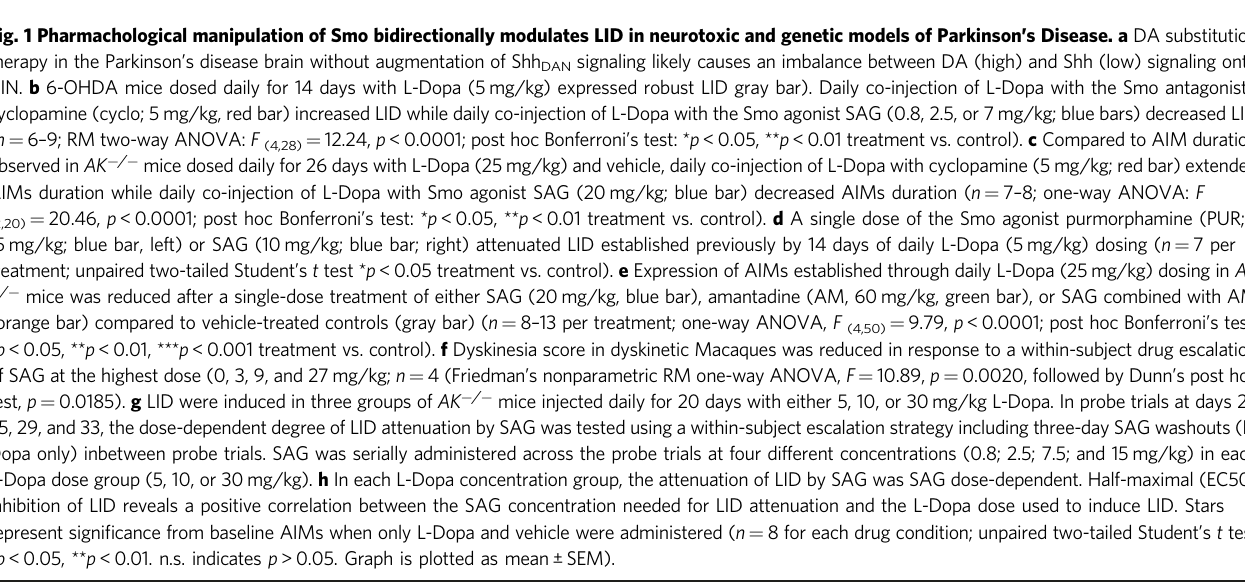
Fig. 1 Pharmachological manipulation of Smo bidirectionally modulates LID in neurotoxic and genetic models of Parkinson ’ s Disease. a DA substitution therapy in the Parkinson ’ s disease brain without augmentation of Shh DAN signaling likely causes an imbalance between DA (high) and Shh (low) signaling onto CIN. b 6-OHDA mice dosed daily for 14 days with L-Dopa (5mg/kg) expressed robust LID gray bar). Daily co-injection of L-Dopa with the Smo antagonist cyclopamine (cyclo; 5mg/kg, red bar) increased LID while daily co-injection of L-Dopa with the Smo agonist SAG (0.8, 2.5, or 7mg/kg; blue bars) decreased LID ( n = 6 – 9; RM two-way ANOVA: F (4,28) = 12.24, p <0.0001; post hoc Bonferroni ’ s test: * p <0.05, ** p <0.01 treatment vs. control). c Compared to AIM duration observed in AK − / − mice dosed daily for 26 days with L-Dopa (25mg/kg) and vehicle, daily co-injection of L-Dopa with cyclopamine (5mg/kg; red bar) extended AIMs duration while daily co-injection of L-Dopa with Smo agonist SAG (20mg/kg; blue bar) decreased AIMs duration ( n = 7 – 8; one-way ANOVA: